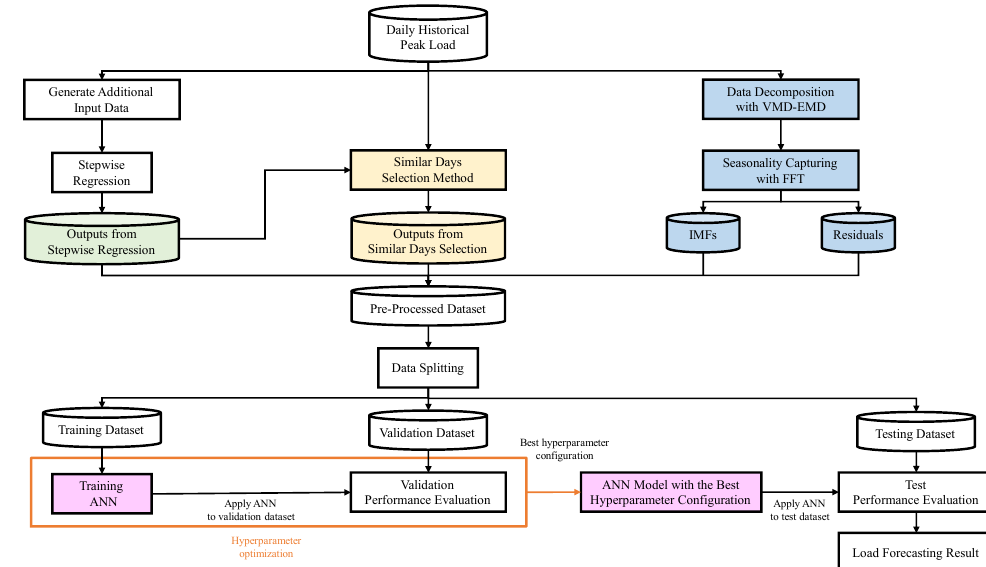
Figure 1. Overall procedure of the proposed model.